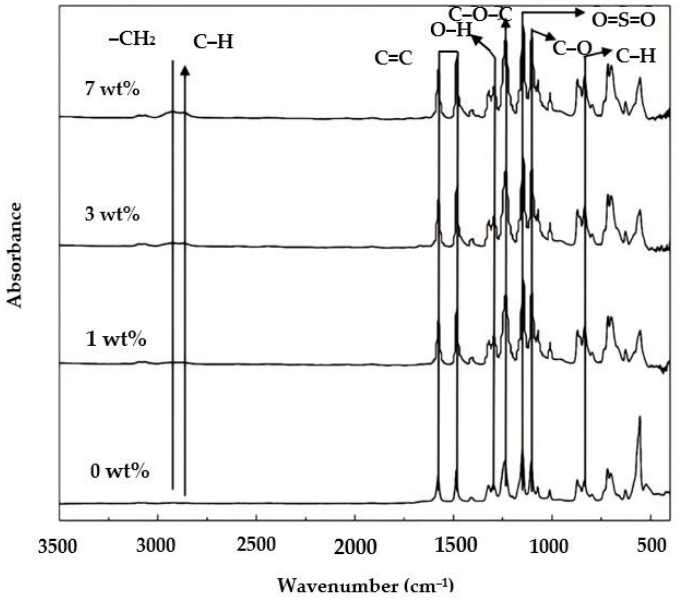
Figure 3. FTIR spectra of the membrane samples.